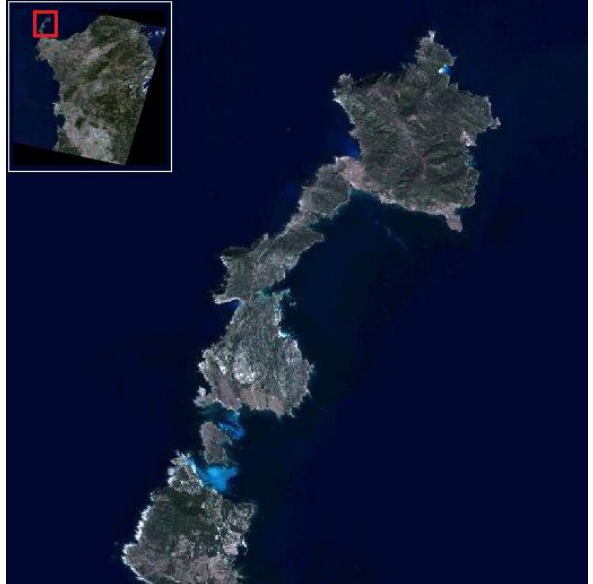
Figure 3. The Asinara island (Italy) and its position with respect to Sardinia. The bands used were 1 (Coastal), 3 (Green), 4 (Red), 5 (Near Infrared). Despite of the images covering almost the same area and being georeferenced in the WGS84 system, the landmask was recalculated for each image because of the different cloud covers and slightly different dimensions. The landmasks were obtained first with an automated procedure and then edited manually to clear masked areas that should have been left unmasked and mask cloudy areas that the automated procedure had not –